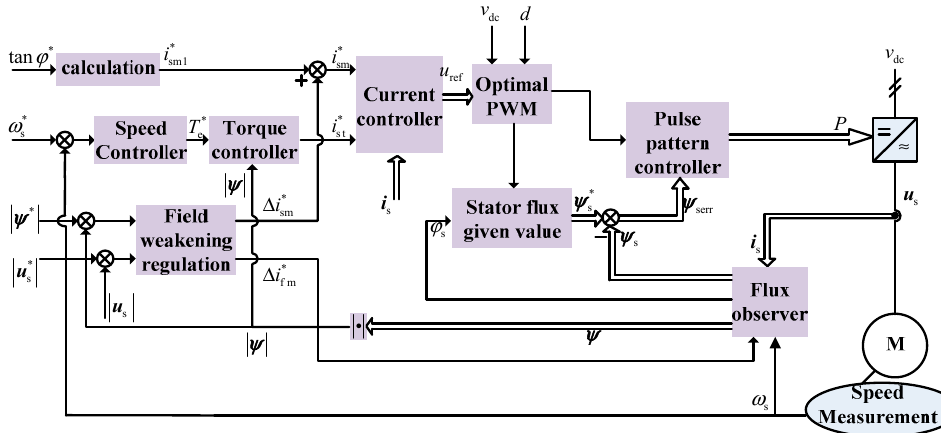
Figure 6. System control block diagram of EESM at low switching frequency.